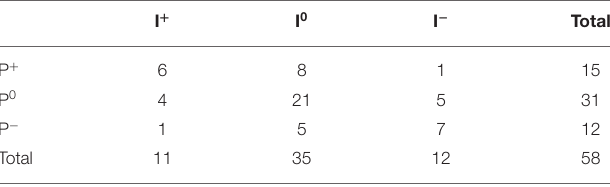
TABLE 2 | Frequency (number of years) corresponding to IOD and ENSO combinations during 1961–2018.